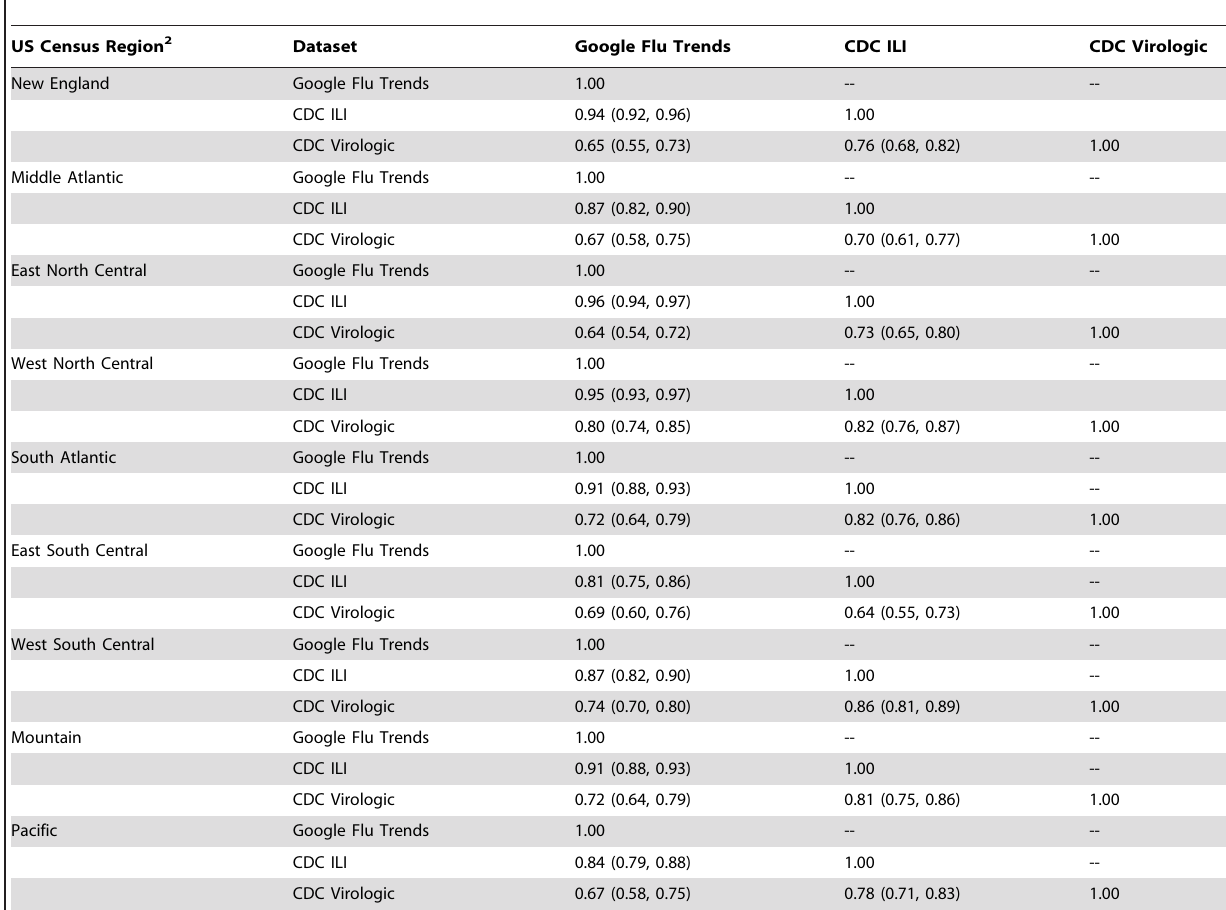
Table 3. Pearson’s Correlation Coefficient Matrix of Data from Three Influenza Surveillance Systems by US Census Region: Google Flu Trends, CDC Influenza-like Illness Surveillance, CDC Influenza Virologic Surveillance, September 28, 2003 through May 17, 2008 1